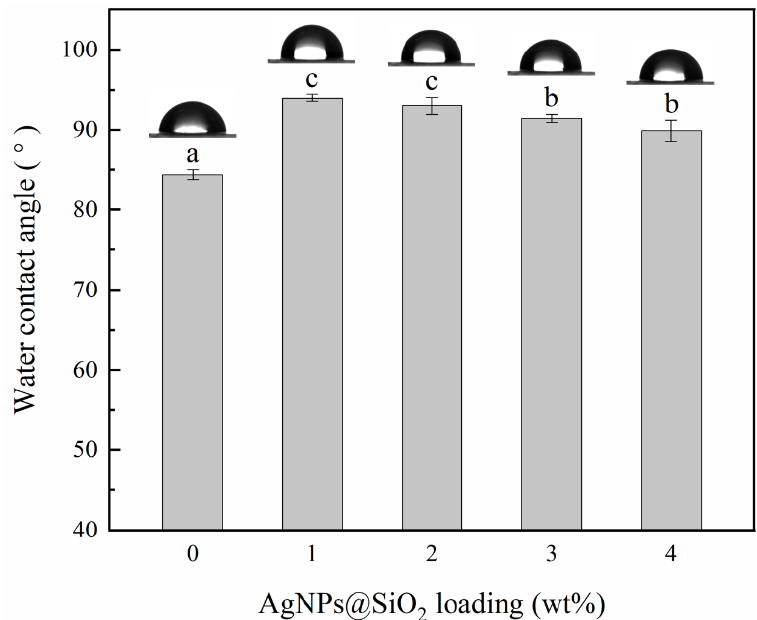
Figure 5. Water contact angle of starch/PBAT antibacterial films loaded with different levels of AgNPs@SiO 2 . a–c : Different letters within the same column indicate significant differences among the samples ( p < 0.05).